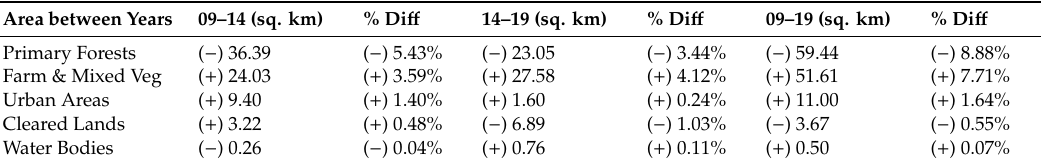
Figure 6. Land cover classification of Cameron Highlands in 2019. Table 5. Di ff erence in land cover growth between